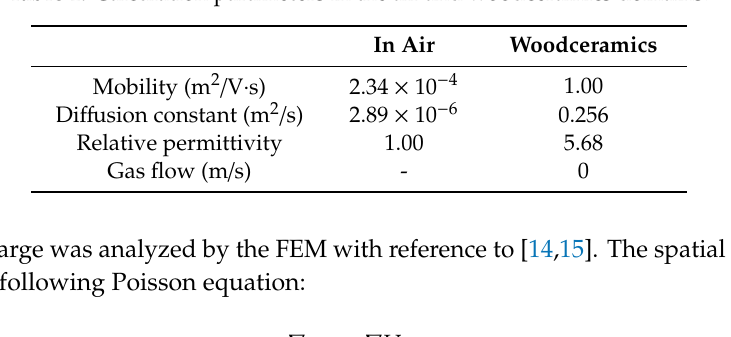
Figure 1. Calculation models for ( a ) the grounded electrode with a stainless-steel electrode and ( b ) the grounded electrode with a woodceramics electrode (which is defined as a solid substance of 10 mm thickness). Table 1. Calculation parameters in the air and woodceramics domains.